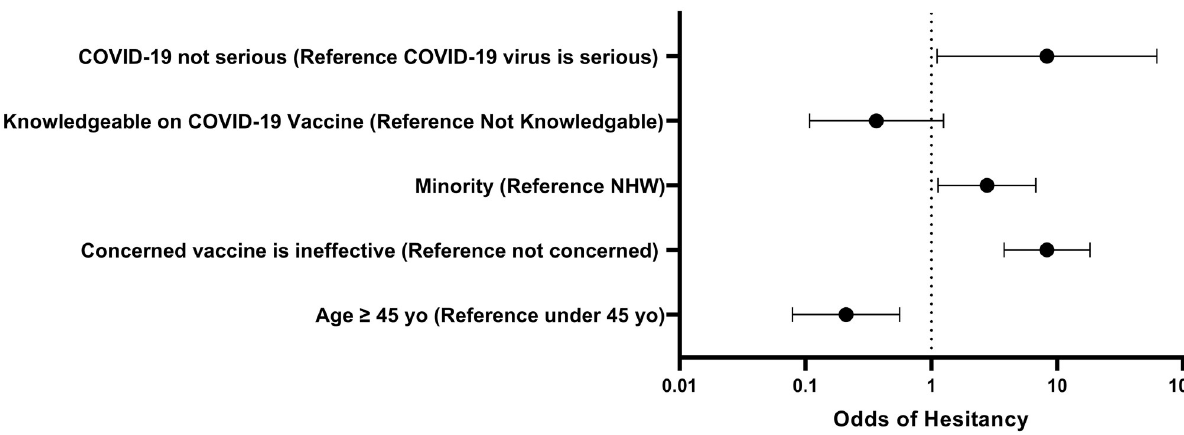
Fig 2. Forest plot of influential factors associated with vaccine hesitancy (S2 Table). N = 181. Individuals who thought COVID-19 was serious, identified as a minority and were under 45 years of age show an increased likelihood of being hesitant toward the COVID-19 vaccine by multinomial regression. NHW—non-Hispanic white Eastern PA